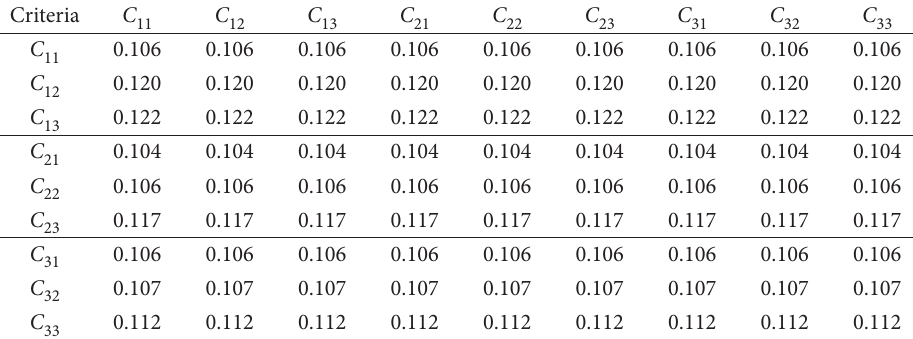
Table 11. Influential weights (global weights) for each criterion (called DANP) Criteria Influential weights Table 12. Influential weights for global weights and local weights Orientations/ Local Methods/ Local Global Ranking Ranking Dimensions weights Criteria weights weights